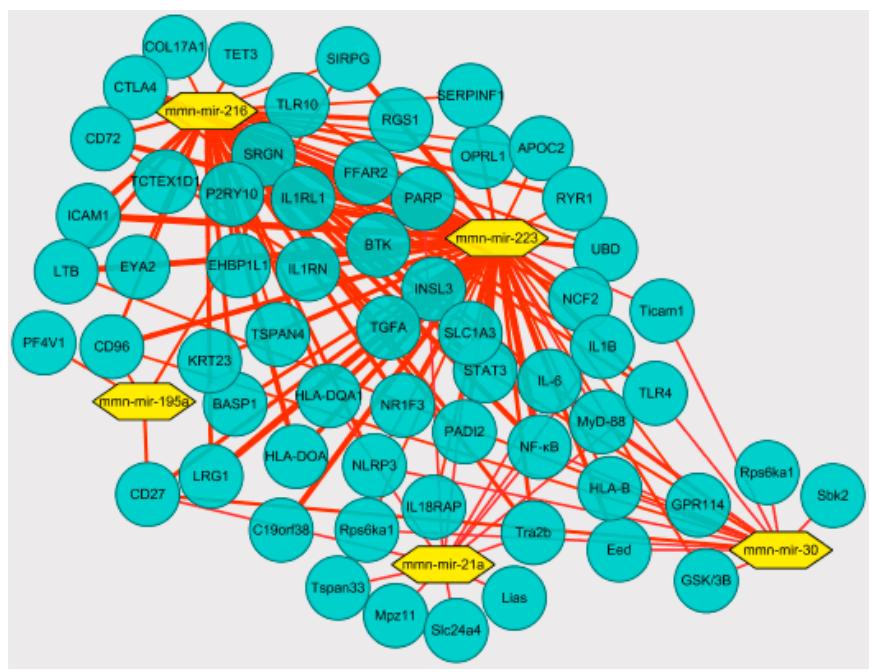
Figure 4. The miR-223 targeted regulation of the TLR4/MyD-88-NF- κ B map. According to the data file of the targeting relationship between differentially expressed miRNAs and mRNA, Cytoscape software was imported for visual operation, and the relationship between mRNA and miRNAs was produced. The network included 5miRNAs and multiple mRNAs, including genes related to inflammation. The blue nodes represent mRNA; the yellow nodes represent miRNAs.